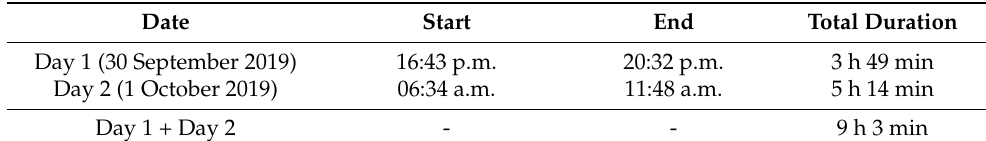
Table 2. The extracted recording times.